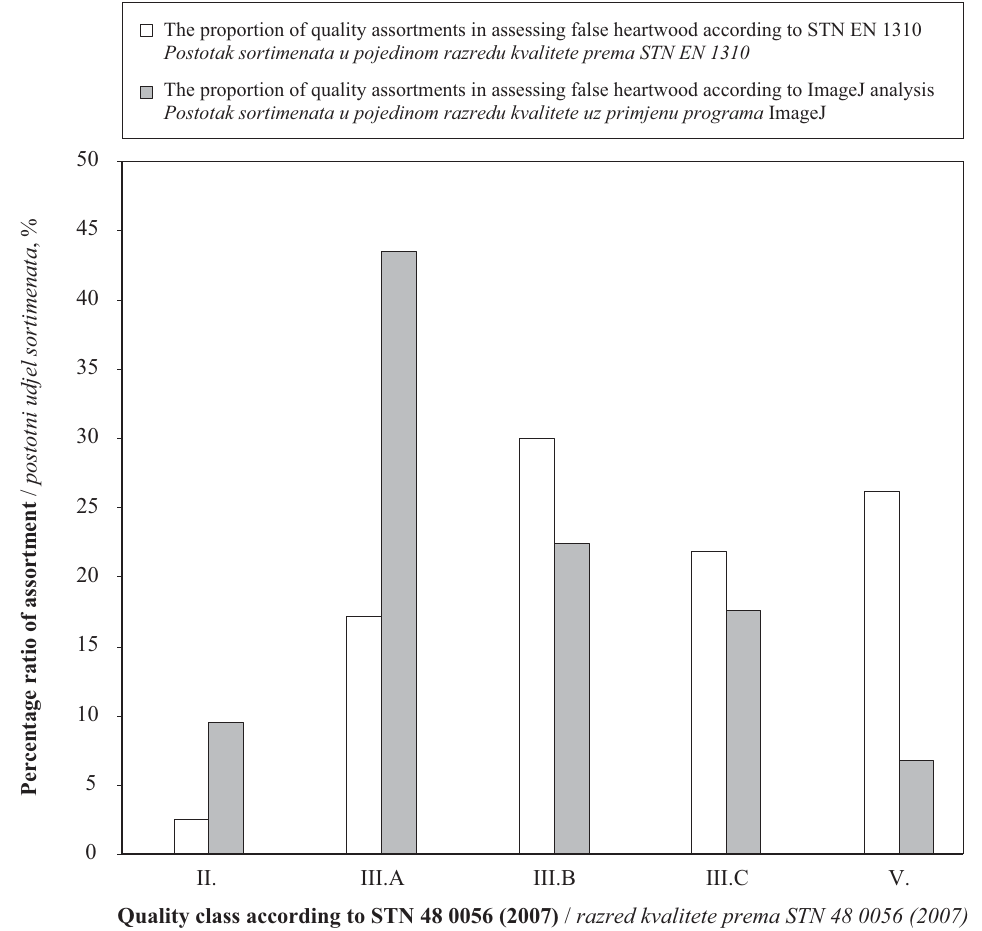
Figure 8 Percentages of assortments in quality grades by assessment of false heartwood according to STN EN 1310 and ImageJ Slika 8 . Postotak sortimenata u pojedinom razredu kvalitete procjenom “lažne srži” prema normi STN EN 1310 i uz primjenu programa